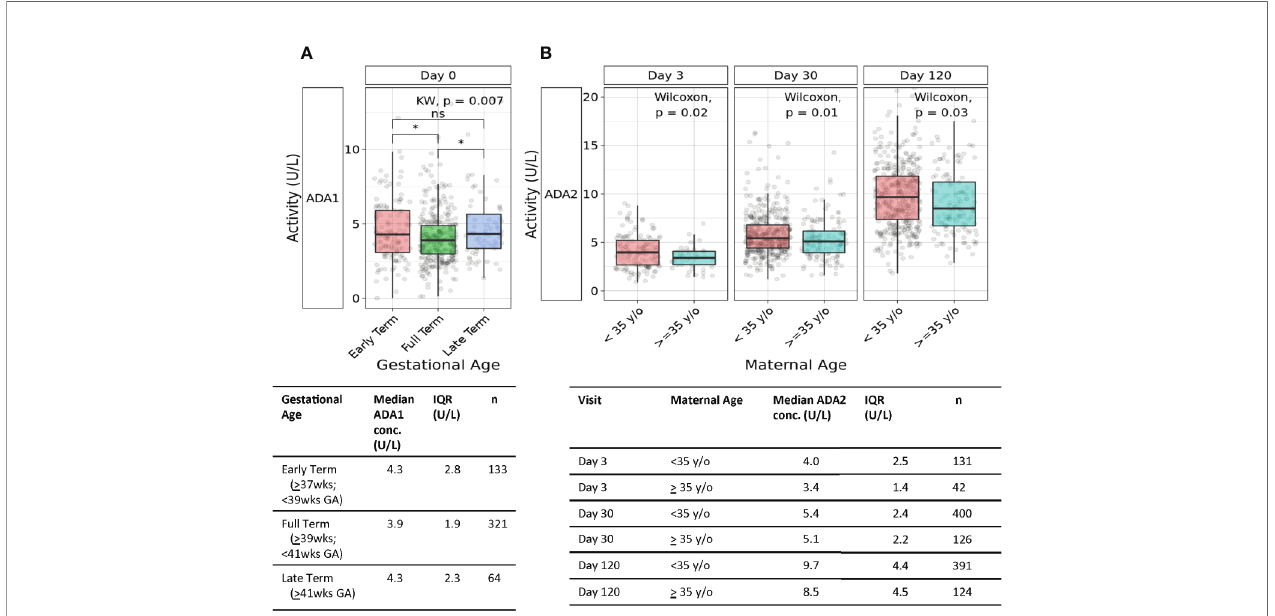
FIGURE 5 | Association of gestational age and maternal age with plasma ADA concentrations. (A) Both early and late gestational age were associated with higher neonatal plasma concentrations of ADA1. Plasma concentrations of ADA1 at Day 0 in the Gambian cohort were signi fi cantly elevated in both early and late-term versus to full-term newborns (n = 133 early-term, n = 321 full-term, n = 64 late-term)(*p<0.05; ns, not signi fi cant). Statistical analyses employed Kruskal-Wallis and Wilcoxon for post-hoc. (B) Greater maternal age was associated with lower ADA2 concentrations during the fi rst four months of life. Concentrations of plasma ADA2 in the Gambian cohort were signi fi cantly elevated at Day of Life 3 (p=0.02), 1 month (p=0.01), and 4 months (p=0.03) (n = 131- 400 infants of mothers <35 years of age, n = 42-126 infants of mothers ≥ 35 years of age). Statistical analyses employed Wilcoxon rank sum